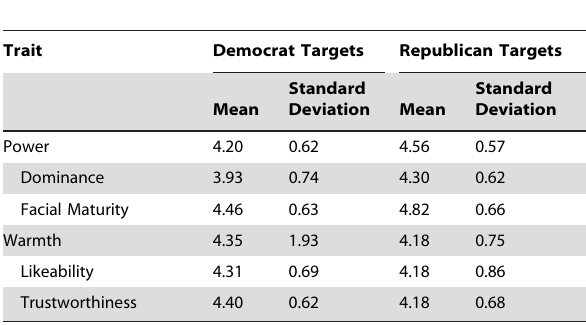
Table 1. Descriptive statistics for the trait ratings in Study 3. Trait